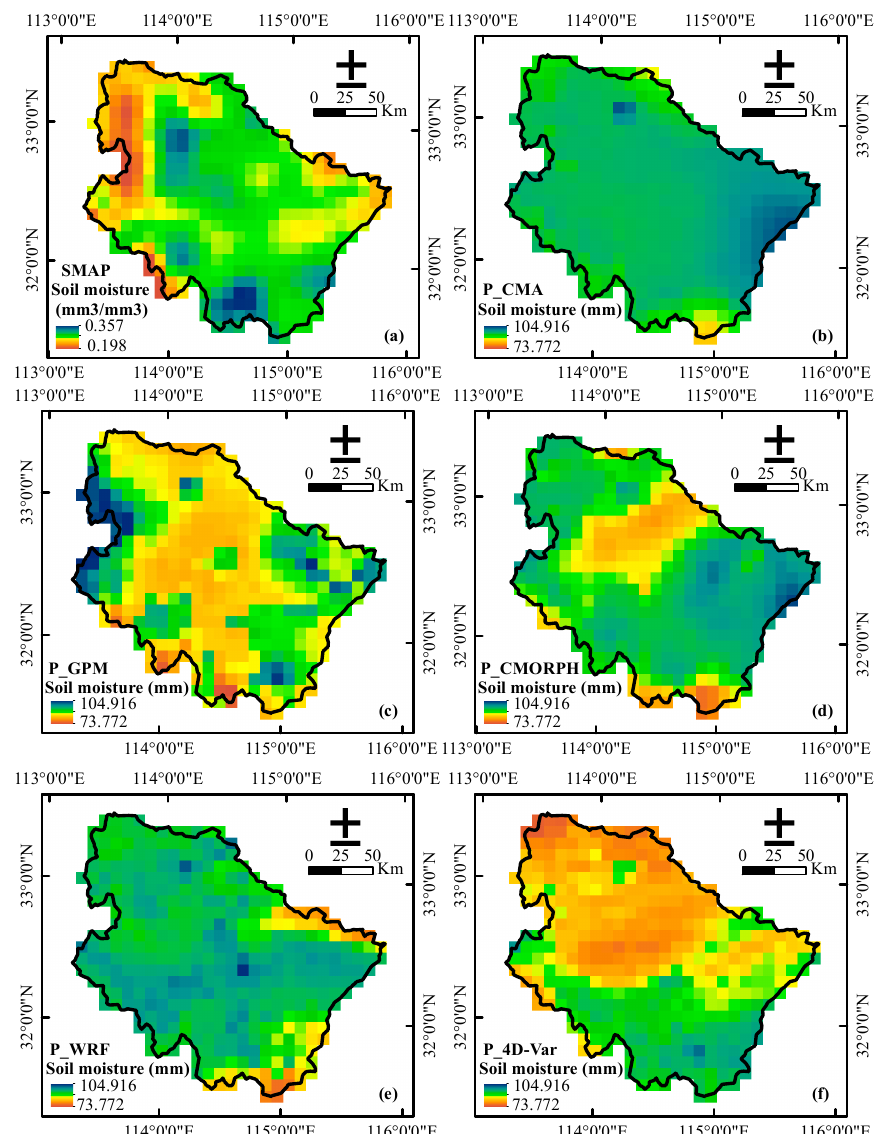
Figure 7. 9-km grid data of the average 3-h soil moisture in the WJB watershed extracted from the SMAP product ( a ) and the P_CMA ( b ), P_GPM ( c ), P_CMORPH ( d ), P_WRF ( e ), and P_4D-Var ( f ) experiments during the study period.